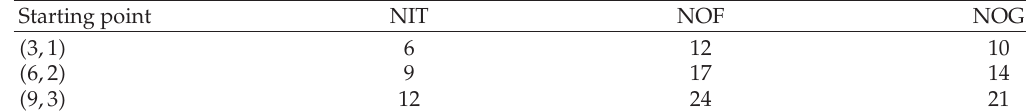
Table 1: Numerical results of Example